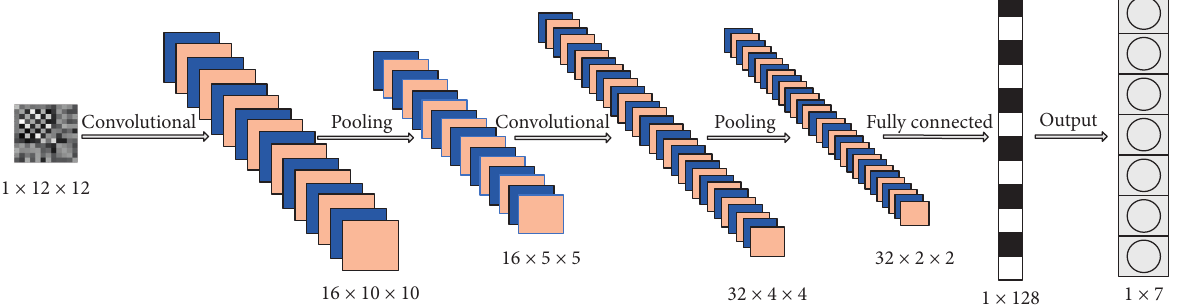
Figure 8: Structure of convolutional neural network in this study.